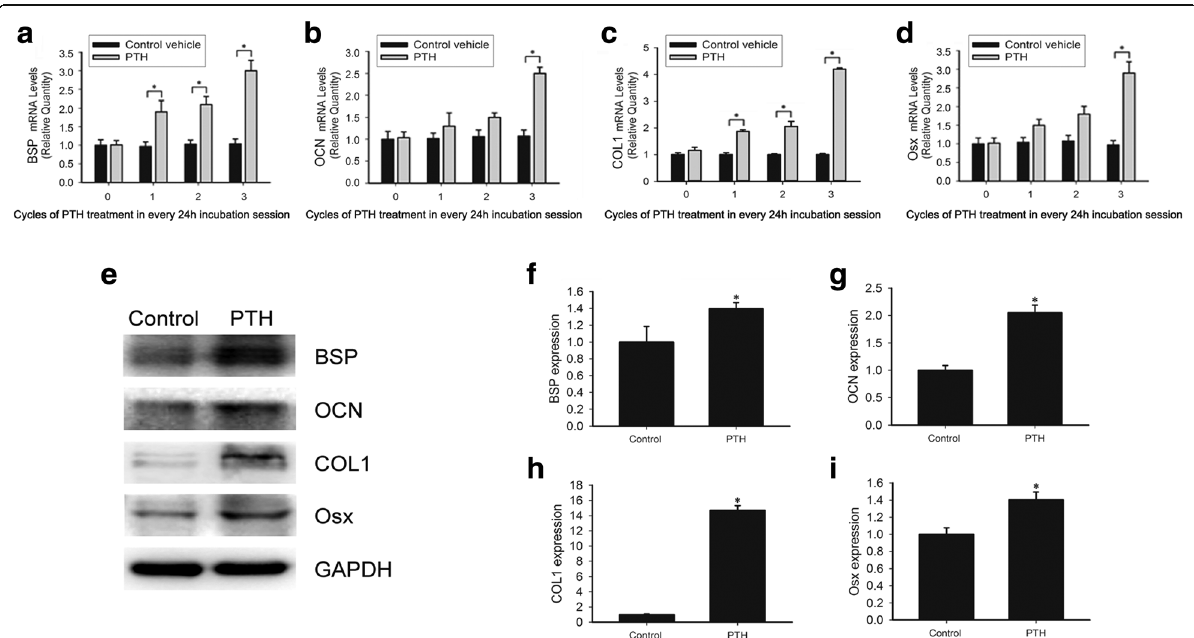
Fig. 4 Intermittent PTH markedly increased expression of some cementogenesis-related biomarkers. a - d The relative mRNA levels of BSP, OCN, COL1 and Osx in vehicle or 0-3 cycles of intermittent PTH treatment groups were determined by qPCR. For the first 6 h in each 24 h cycle, OCCM-30 cells were treated with vehicle or PTH (50 ng/ml) medium, then cells were cultured in fresh medium for the last 18 h in each cycle. Total RNA was subjected to qPCR. Relative mRNA expression levels were normalized to GAPDH as an endogenous reference. e The protein levels of BSP, OCN, COL1 and Osx in vehicle or 3 cycles of intermittent PTH treatment groups were determined by western blot. f - i Densitometry of bands was performed and normalized to GAPDH and fold change was determined relative to the control group. The experiments were repeated 3 times. Bars represent mean ± SD. * p < 0.05